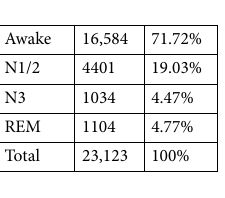
Table 3. Number of data points and overall percent of data points at each sleep stage in the dataset.